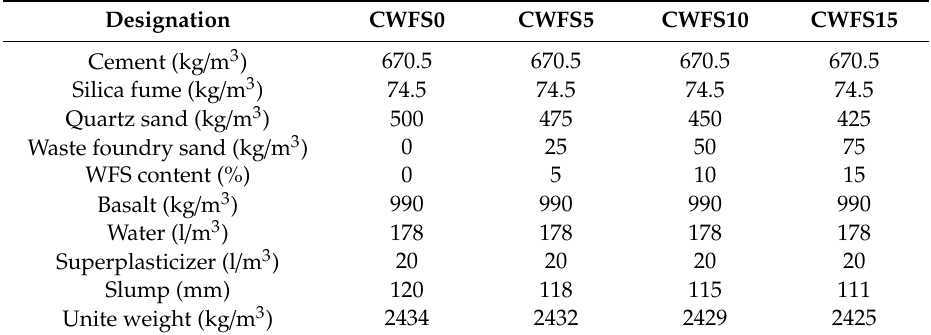
Table 6. Ultra-high performance concrete (UHPC) mixture proportion and properties of fresh concrete.